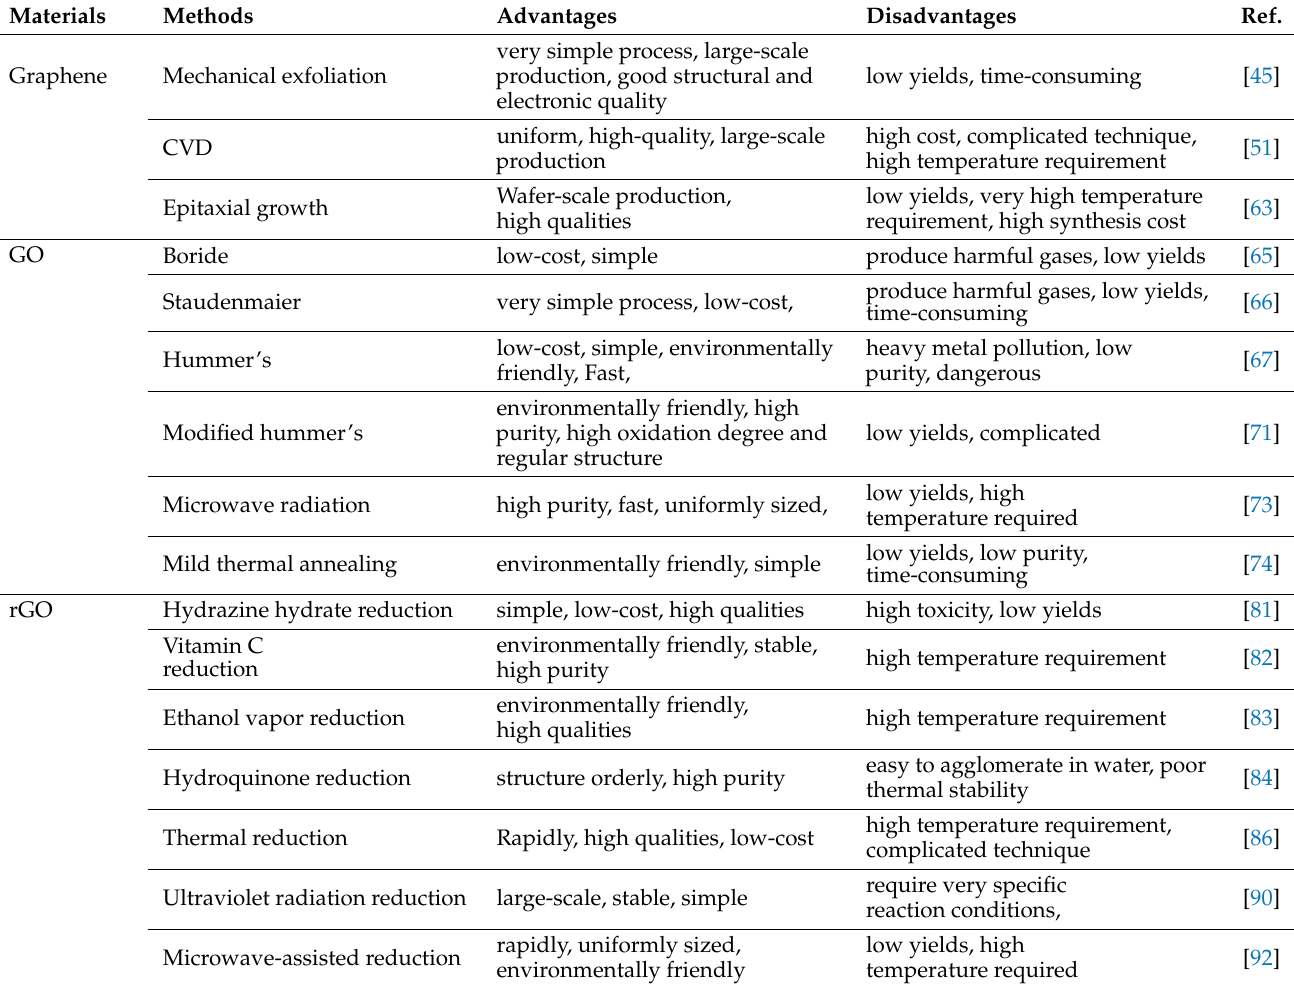
Table 1. Preparation methods of graphene and its derivatives and their advantages and